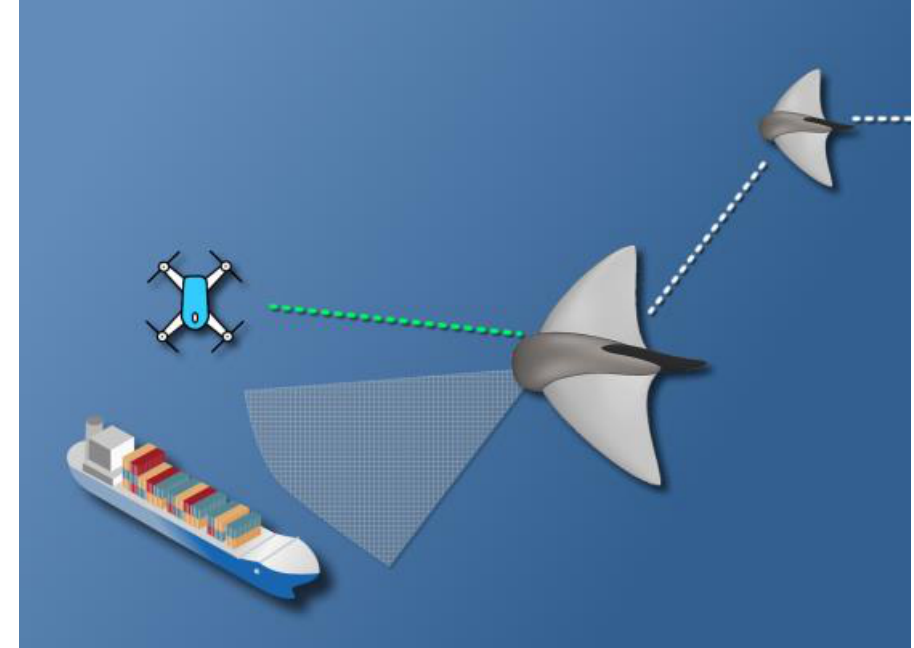
Figure 12. HSS for marine traffic control and borders security management.